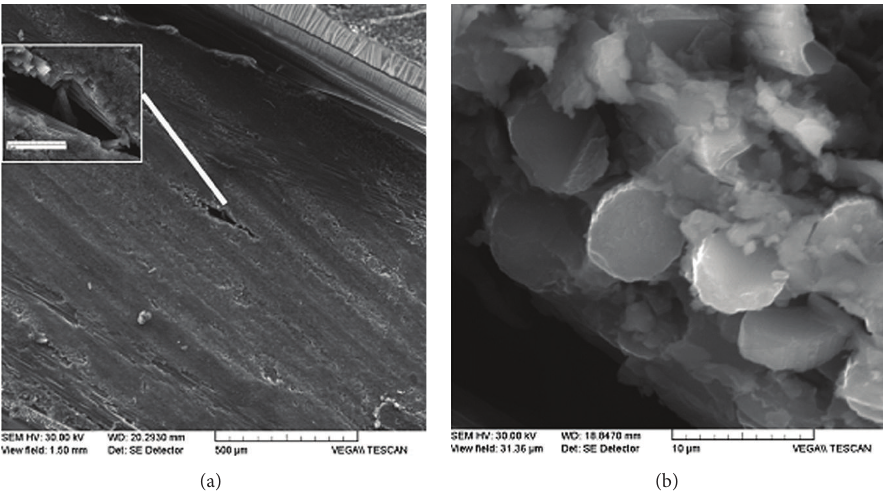
Figure 9: (a) The entire thickness cross-section of a sample manufactured at 50psi. (b) Smaller voids also formed at 50psi sample.